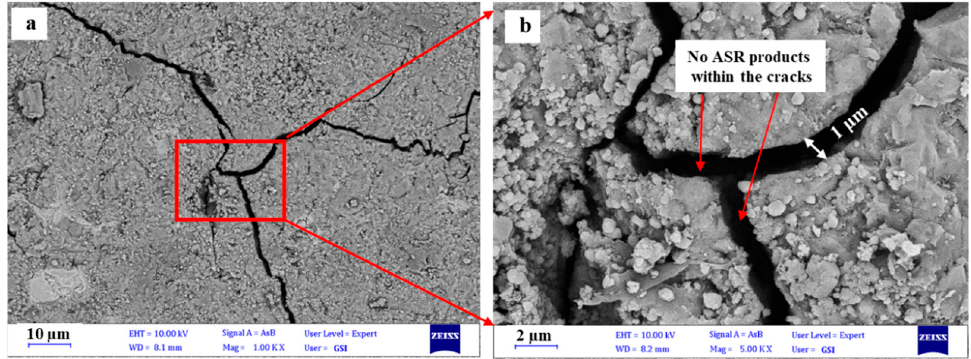
Figure 11. BSEM micrographs of the dolomite aggregate concrete prism samples after 6 months: ( a ) the micrograph with 10 µm magnification; ( b ) the micrograph with 2 µm magnification.